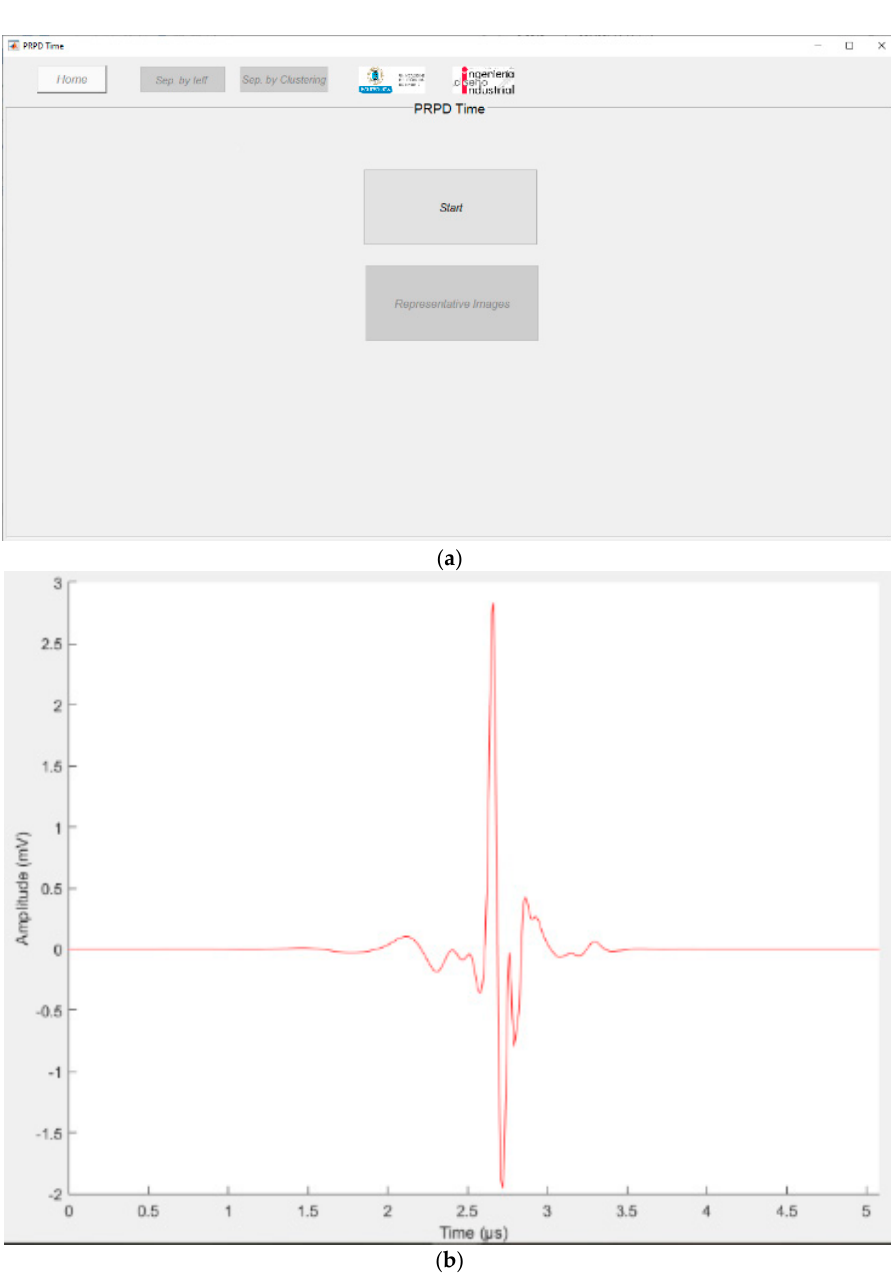
Figure 2. ( a ) Phase-resolved partial discharge (PRPD)-time tool, login window and ( b ) visualization of one of the pulses